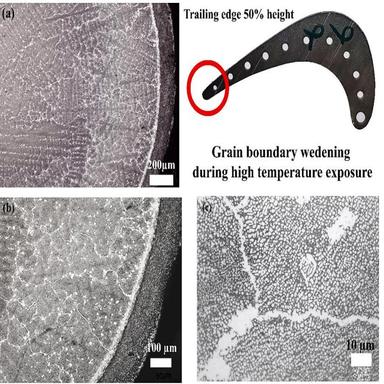
The continuous grain boundary in the TE of the 50% airfoil height.